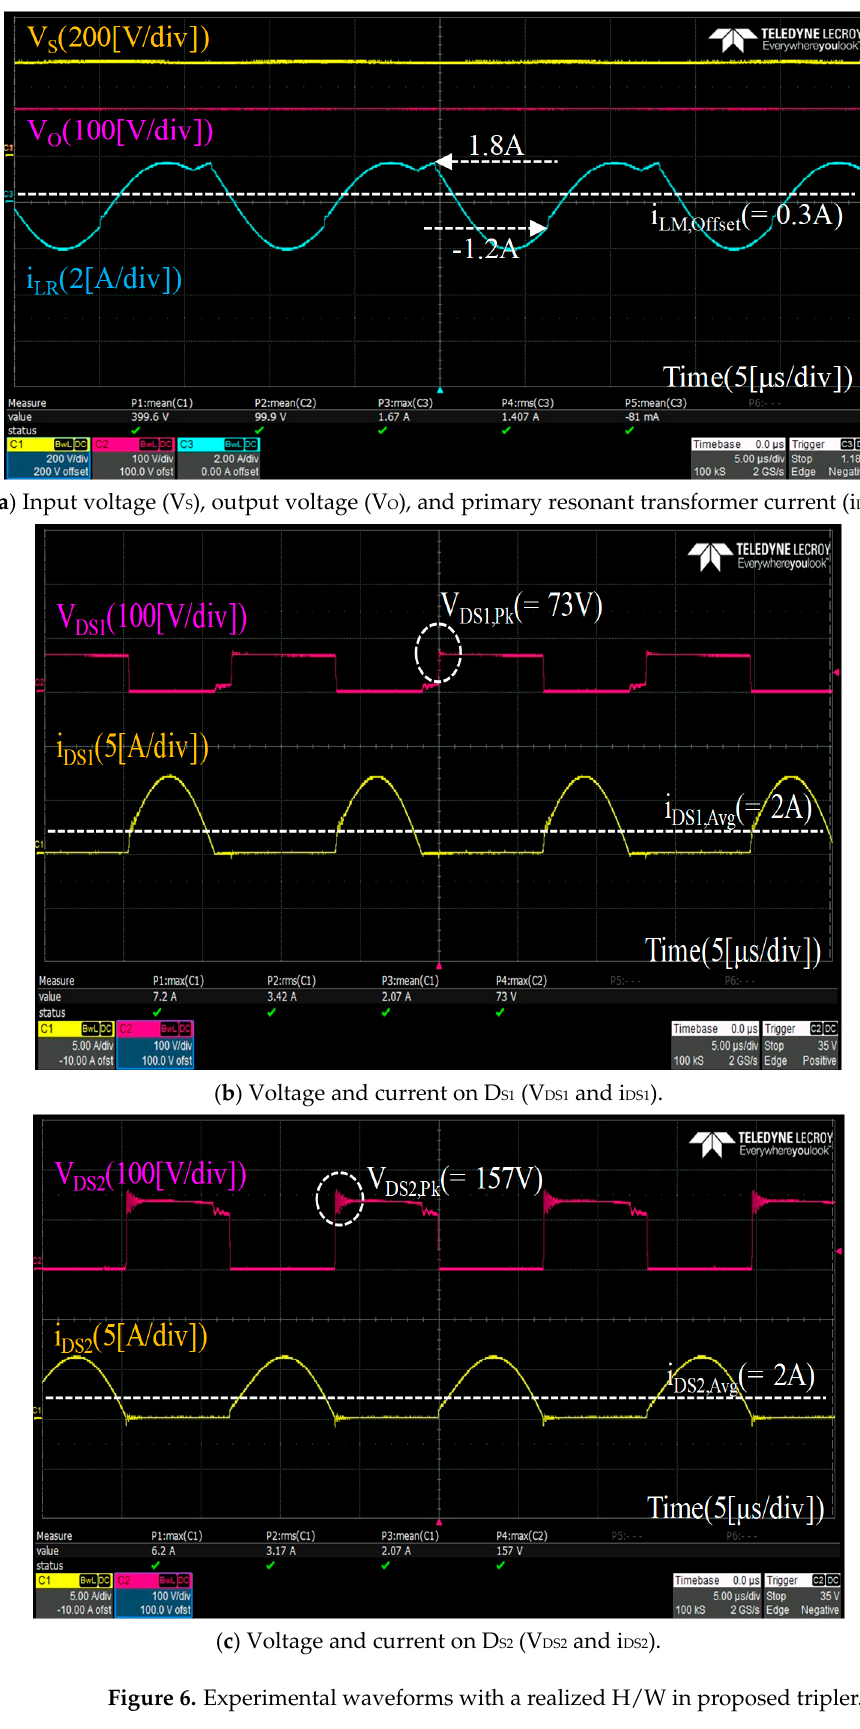
Figure 6. Experimental waveforms with a realized H/W in proposed tripler.